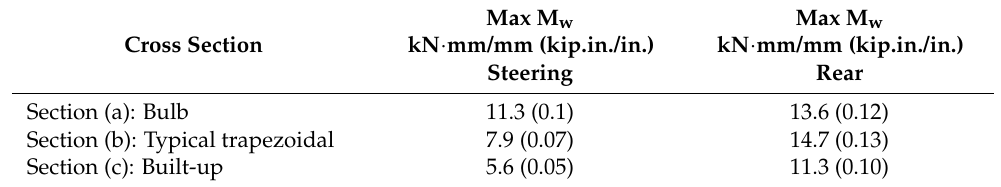
Figure 14. Rib local bending moment distribution under the rear load footprint from shell analysis. Table 2. Shell Analysis Comparisons.